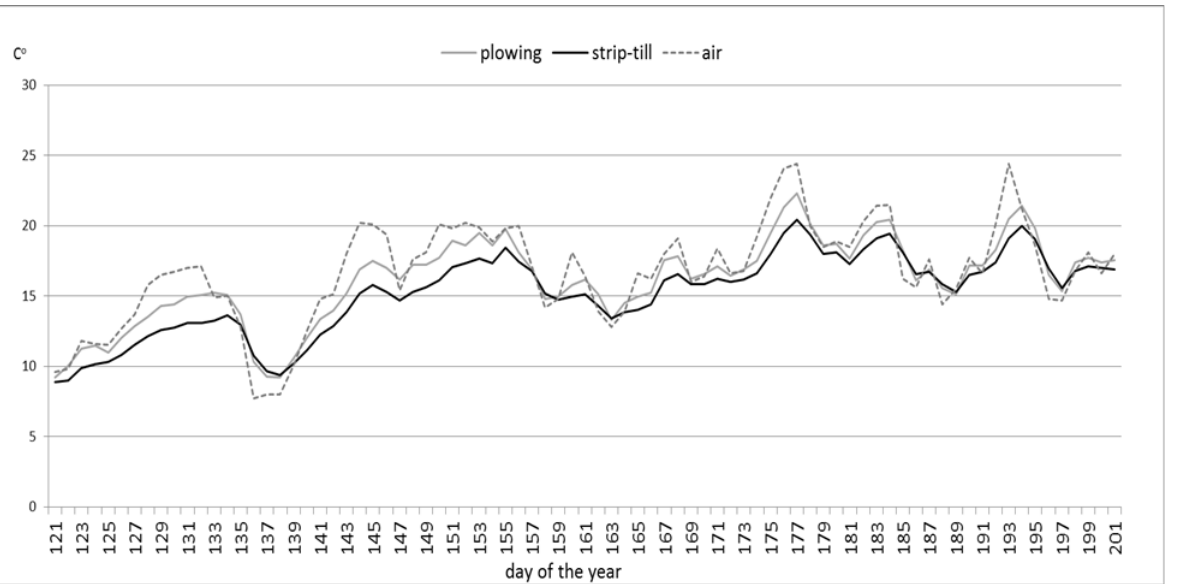
Table 1. Meteorological conditions (30-year mean) in the area of the field experiment.